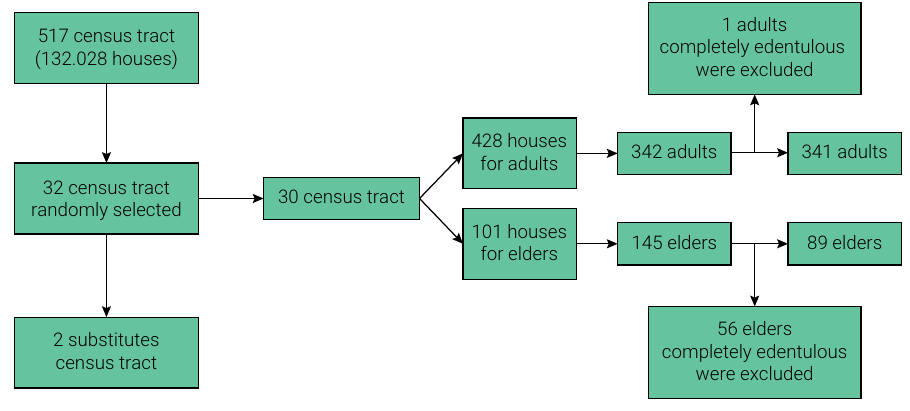
Figure 1. Flowchart of study